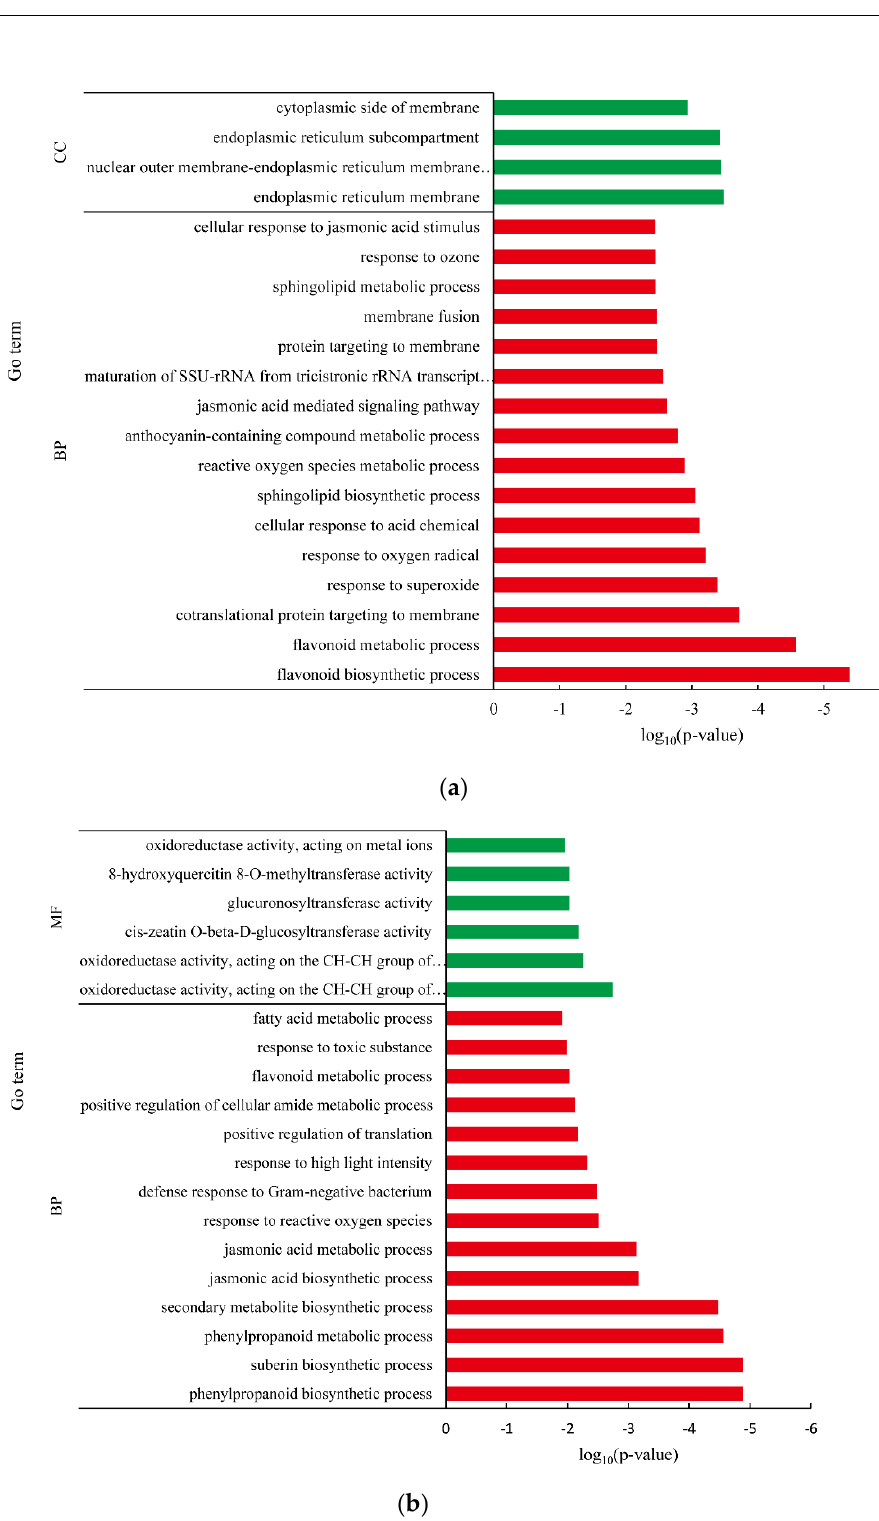
Figure 4. GO enrichment of DEGs in the root of Xiangshu99 vs. Zhezi No1. ( a ) upregulated genes; ( b ) downregulated genes. GO terms belonging to biological processes (BP), cellular components (CC), and molecular functions (MF).